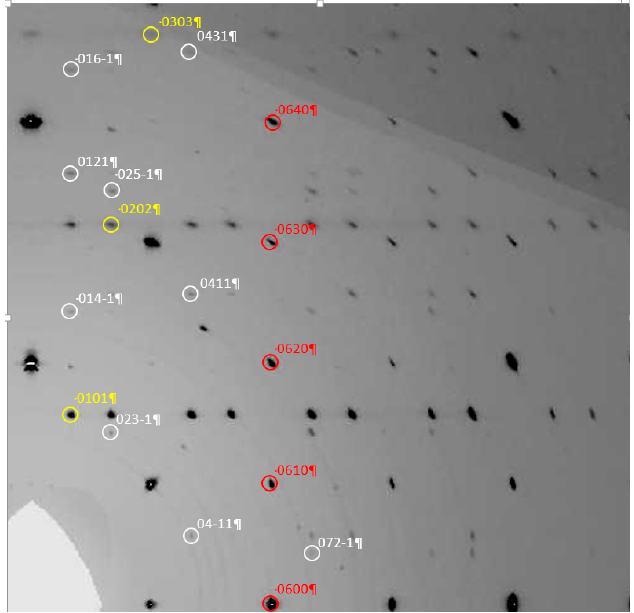
Table 1. Crystallographic data for Y3Ru2.